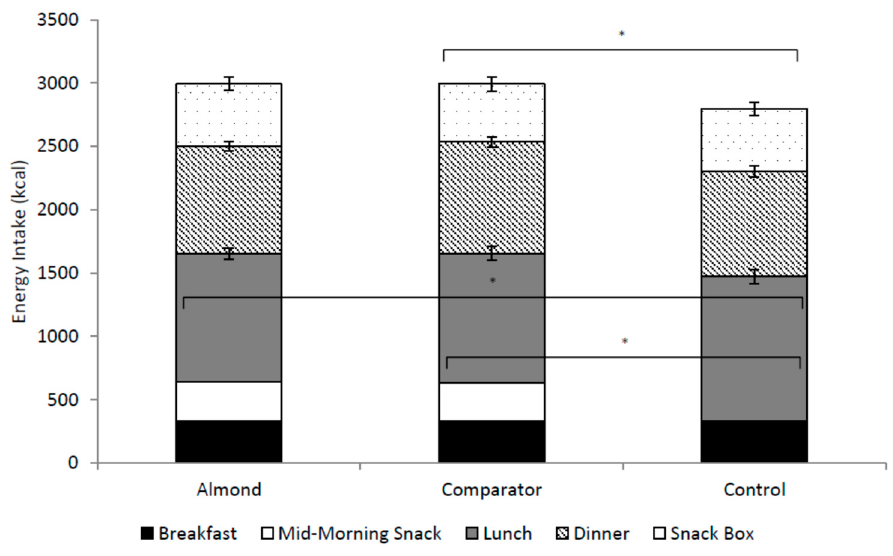
Figure 3. Total energy intake (kcal) for the di ff erent snack conditions. * p < 0.05.